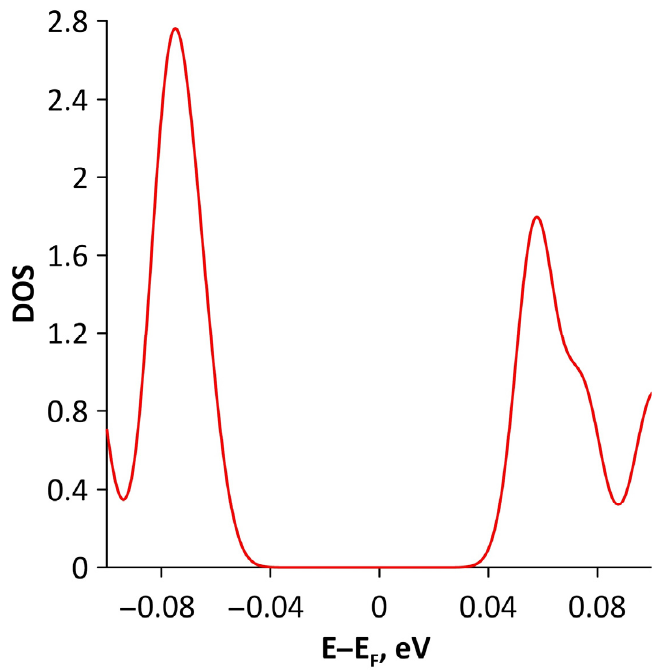
Figure 15. Fragment of DOS near the Fermi level (shifted to 0 eV) of borophene/ZnO heterostructure under uniaxial stretching by 10%.